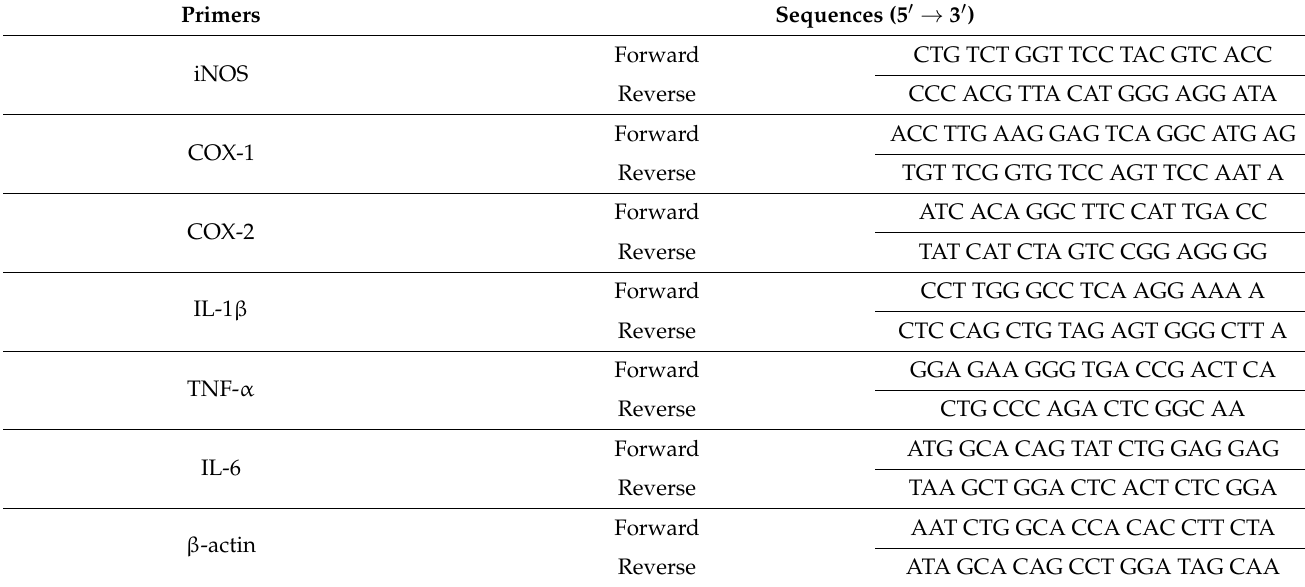
Table 2. Primer sequences for PCR and Real Time